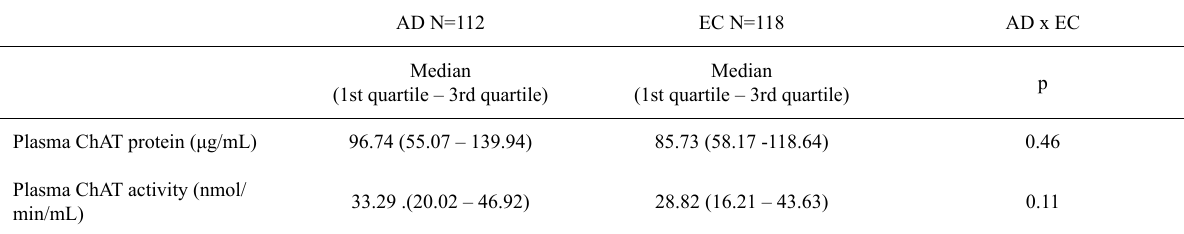
Table 2 – Protein and activity of soluble choline acetyltransferase (ChAT) in plasma of patients with AD and elderly controls